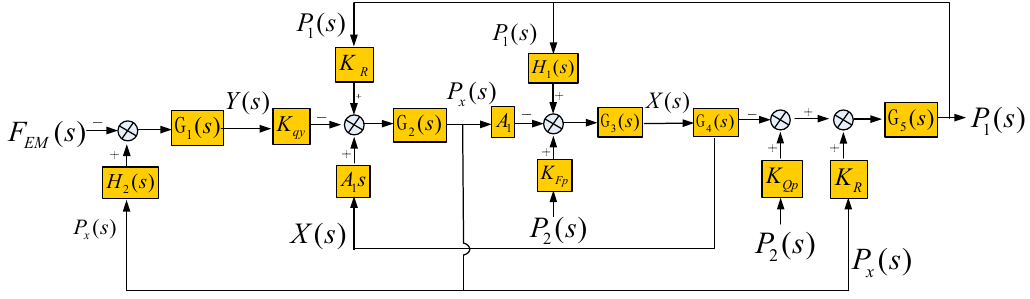
Figure 7. Block diagram of proportional relief valve control system with energy regeneration system.